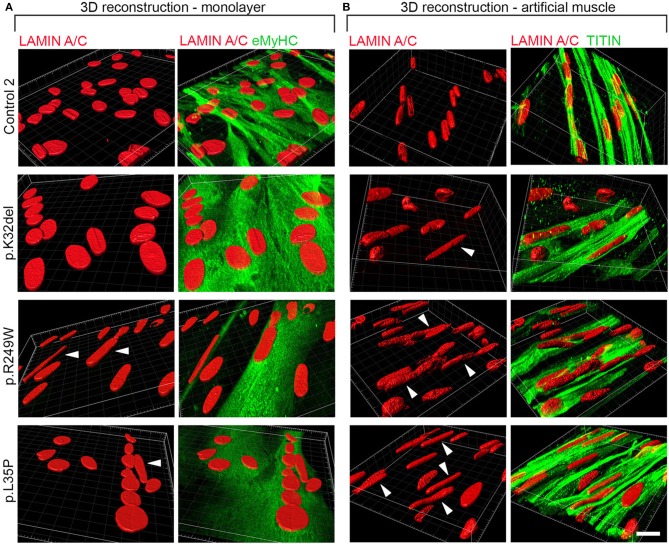
Abnormally elongated nuclei characterize LMNA-mutant iPSC-derived myotubes differentiated in either monolayer culture or as 3D artificial muscles. LMNA-mutant HIDEMs K32del, R249W, and L35P were either terminally differentiated into multinucleated myotubes in (A) monolayer cultures or (B) within 3D artificial muscles. Three dimensional computer-generated reconstructions from confocally-imaged cells immunolabeled for Lamin A/C and the myogenic markers embryonic myosin (eMyHC) or Titin. Arrows head: abnormally elongated nuclei. Scale bar: 20 μM.